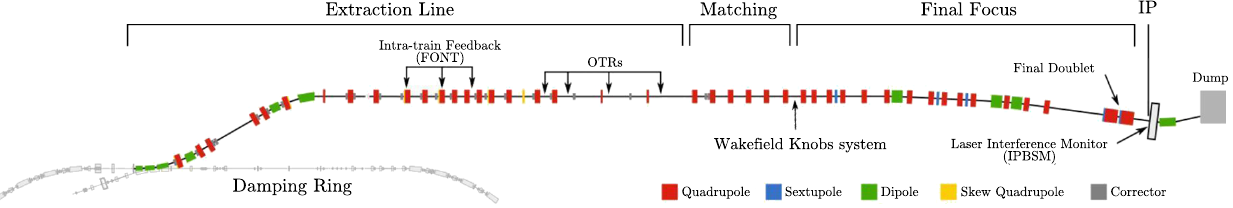
FIG. 1. Schematic layout of ATF2 beam line.